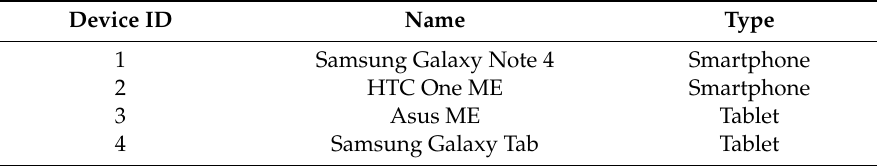
Table 2. Participating devices in the testing scenarios.